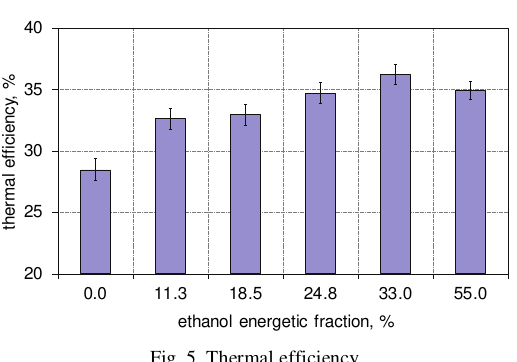
Fig. 5. Thermal efficiency